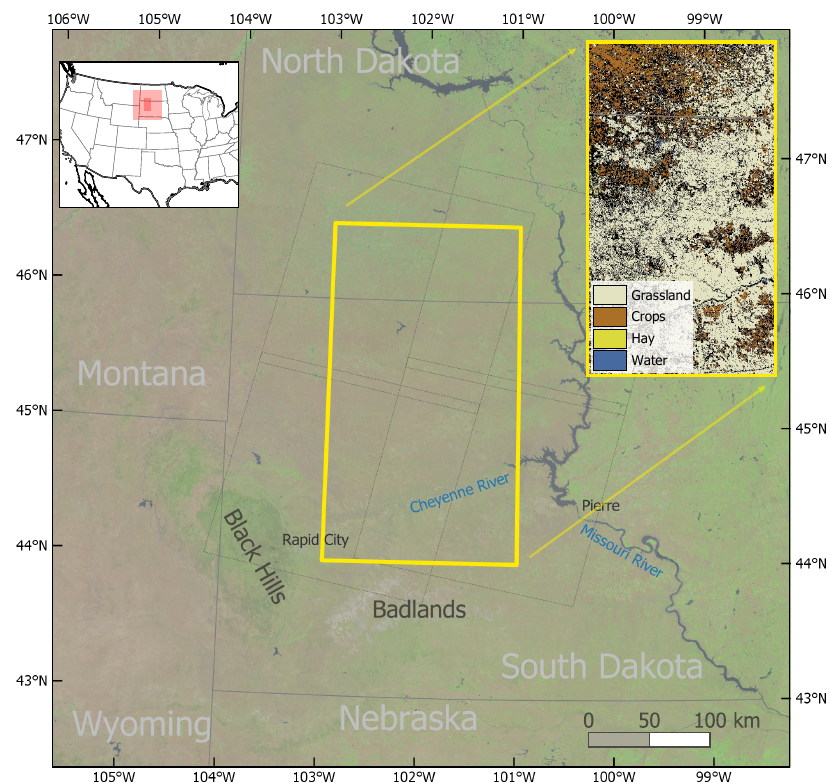
Figure 1. The location of the study area in the western Dakotas (yellow box) shown over a Landsat natural color mosaic of late summer (Landsat 8; July 15–Aug 15; 2013–2016). The four main Landsat scenes used in this study are outlined with dotted grey lines. The filtered National Land Cover Database for the study area is shown in the panel in the upper right (black = not used for this study, tan = grassland, dark brown = crops, yellow = pasture/hay, blue = water).